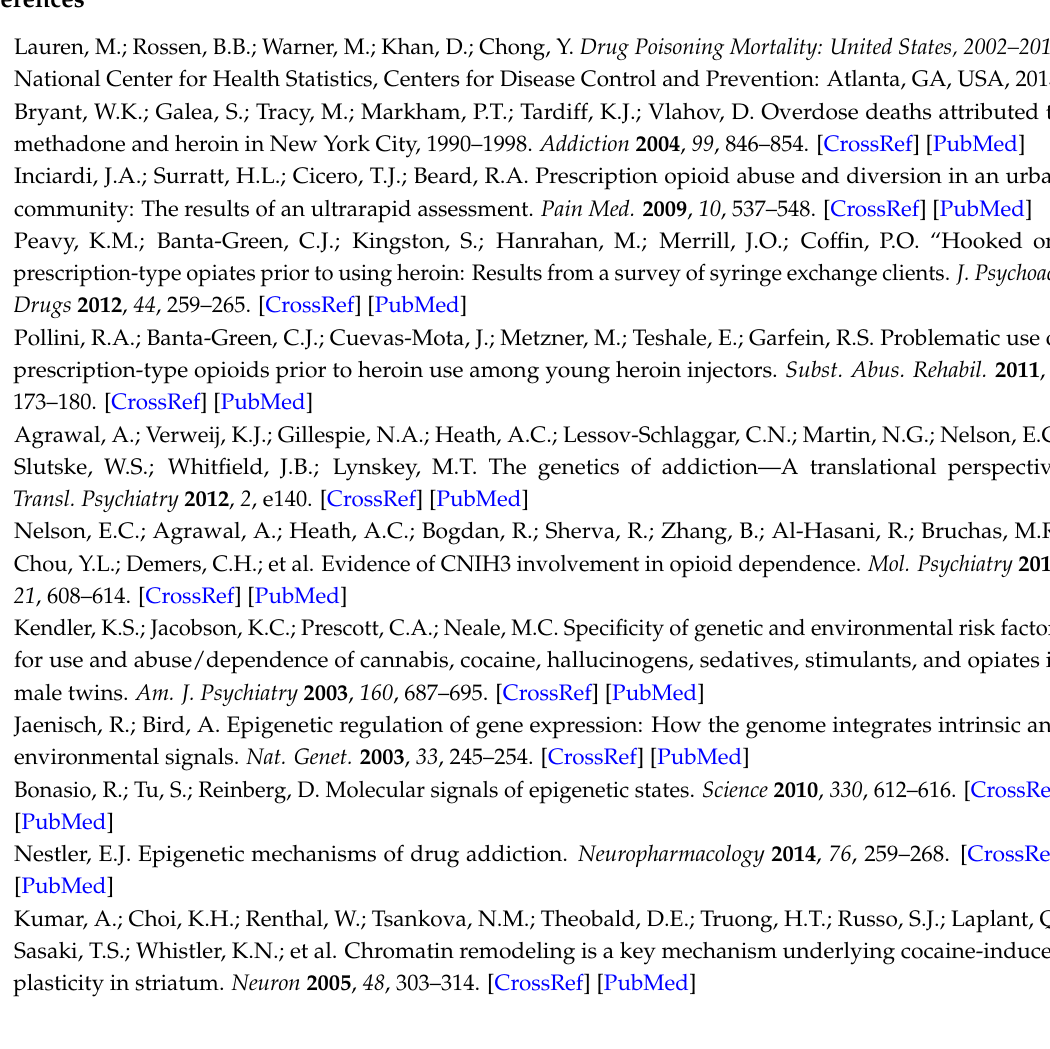
Table S1: Summary of demographics for the specimens used in the study, Table S2: Analysis of differential gene expression (DE) between Glu- and GABA-neurons, Table S3: Differentially methylated sites (DMSs) detected when comparing heroin users vs. control subjects, or suicide completers vs. control subjects, Table S4: Overlap between heroin associated- and suicide-associated DM sites (hyper- or hypoDMSs), Table S5: Differentially methylated genes (DMGs) between heroin users vs. control subjects, or between suicide completers vs. control subjects, Table S6: Gene ontology functional annotation analysis of DMG sets using WebGestalt tool, Figure S1: Estimated proportions of NeuN(+) and NeuN( − ) nuclei in the FACS-separated neuronal nuclear preparations from the current study, Figure S2: Comparison of DM values for N = 1298 heroin vs. control DM sites between the initial analysis and the analysis which excluded 10 oldest control individuals, Figure S3: Assessment of influence of the duration of heroin use on the DM values for N = 1298 heroin vs. control DMSs, Figure S4: Graphic representation of the gene ontology annotation analysis of DMG sets using WebGestalt tool. ( A ): hyperDMheroin gene set, ( B ): hypoDMheroin gene set, ( C ): hyperDMsuicide gene set. No enriched gene ontology terms were found for hypoDMsuicide gene set. Data Availability: Data are available at GEO (GSE98203). Acknowledgments: National Institute of Drug Abuse (R21DA031557 to SD) and U.S. Department of